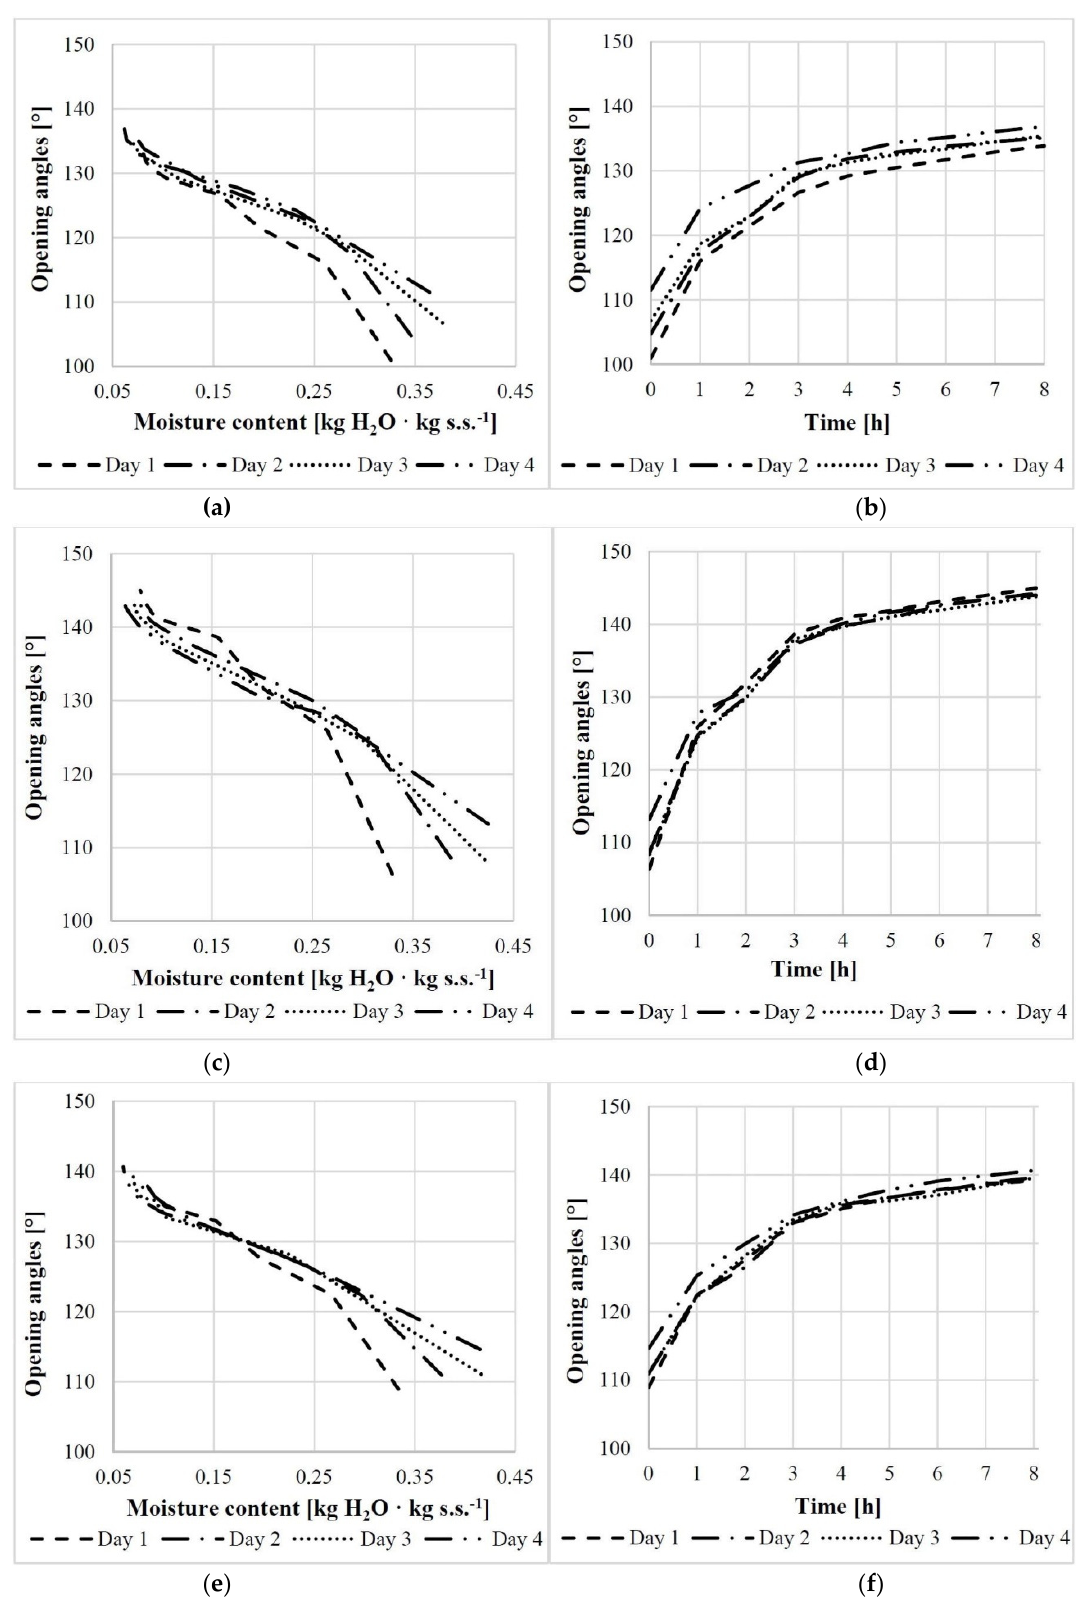
Figure 4. Relationship between the scale opening angle and moisture content/process duration for scales obtained from the base ( a , b ), middle ( c , d ), and apex ( e , f ) of cones.